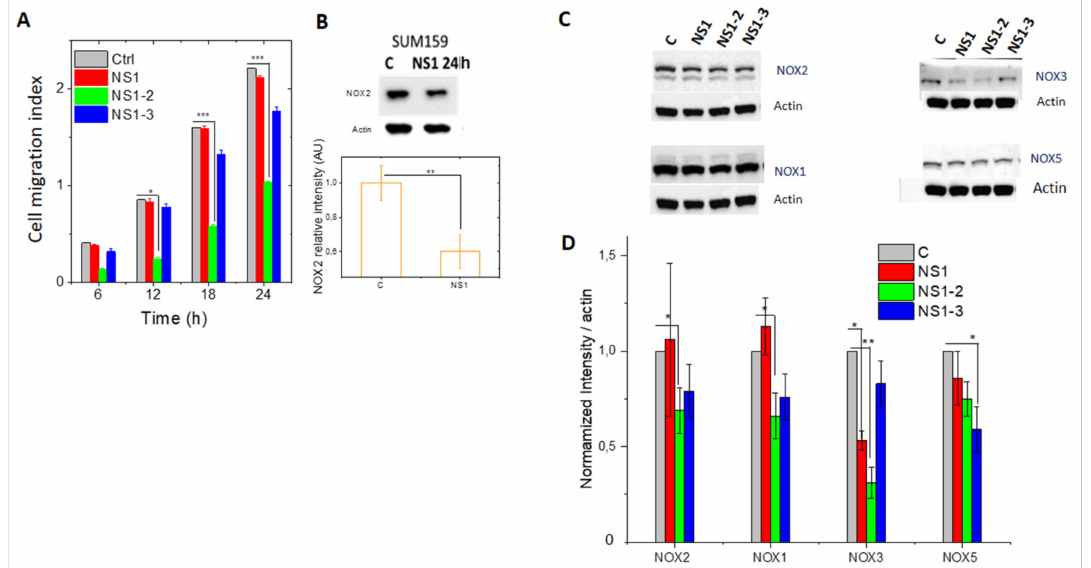
Figure 6. ( A ) Effect of 50 µ M NS1 (mixture of isomers), NS1-2, NS1-3 on the migration of SUM159 breast cancer cells, see also Supplementary Figure S10; ( B ) Western blot analysis of NOX2 in SUM159 cells treated or not with NS1 (50 µ M) and their quantification after 48 h treatment; ( C , D ) Representative Western blots of NOX2, NOX1, NOX3 and NOX5 in SUM159 cells treated or not with NS1 or its isomers for 48 h and their